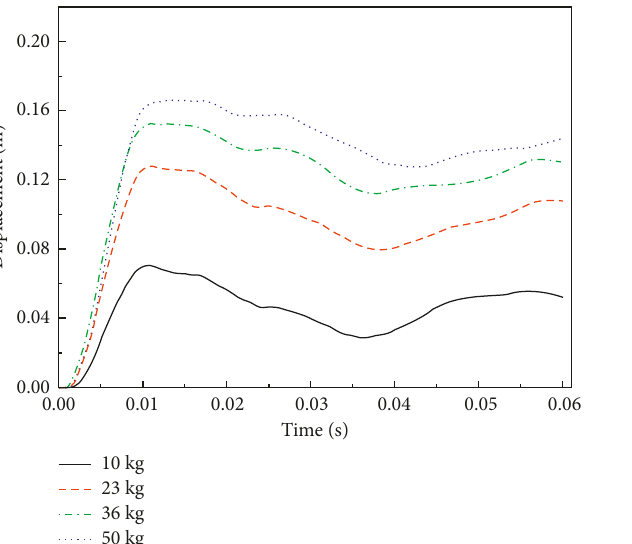
Figure 20: Displacement-time curves of the roof.